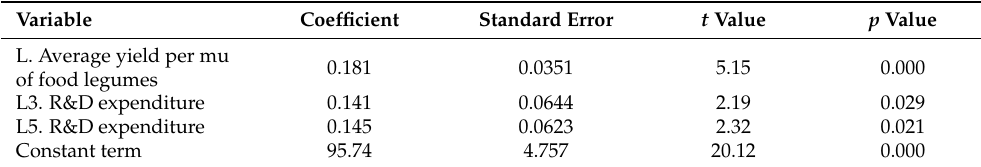
Table 1. Fixed effect panel data model estimation of average yield per mu of food legumes in 31 provinces during 2002–2020.